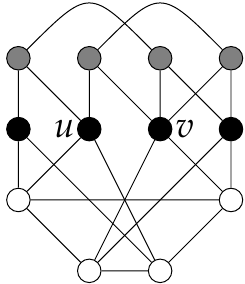
Figure 5. In the depicted graph G , the set S is formed by the white vertices, set A is formed by the black vertices and set B is formed by the gray vertices. Note that γ (cid:48) ( A , B ) = 2 (the set { u , v } is a ( G ) = γ (cid:48) ( A , B ) -set) and γ g 1 t